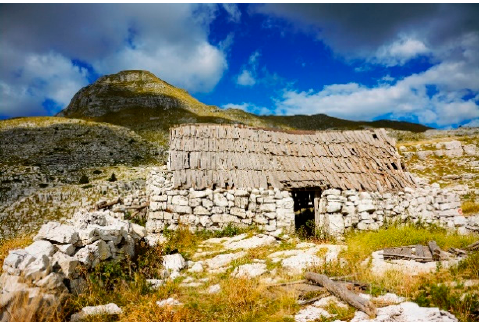
Figure 29. Roof cover of skudla - Bankanjski katun photo: I. Lakovi ć .